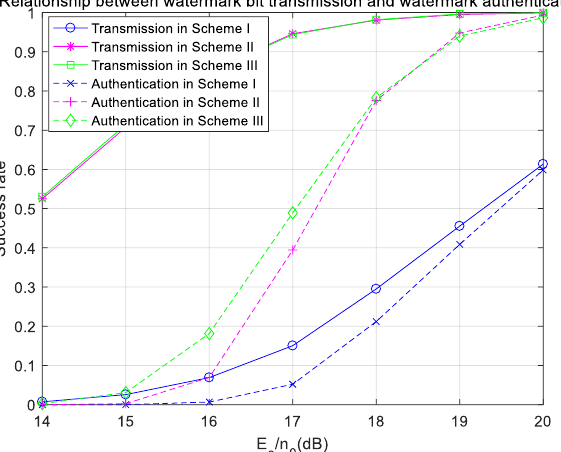
Figure 12. Success rates of watermark-bit transmission and watermark authentication under ideal synchronization in the Gaussian channel.